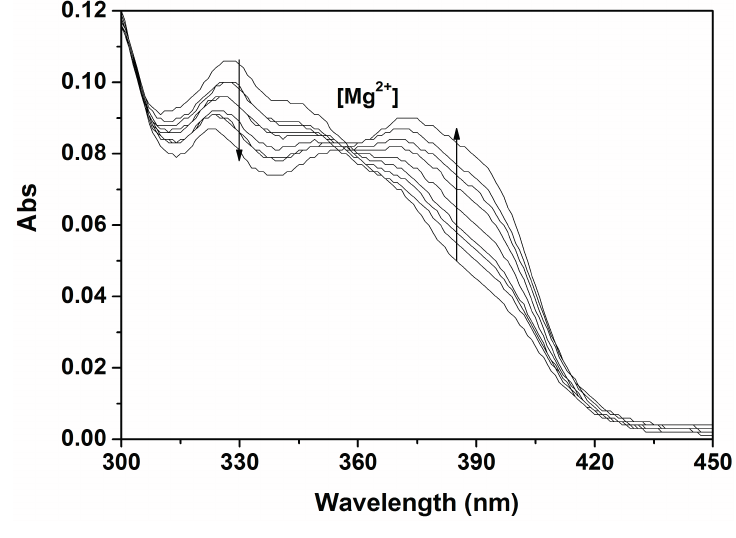
Figure 3. Absorbance spectra of P (10 μ M) in ethanol-water solution (9:1, v:v, 20 mM HEPES, pH 10.0) in the presence of different amounts of Mg 2+